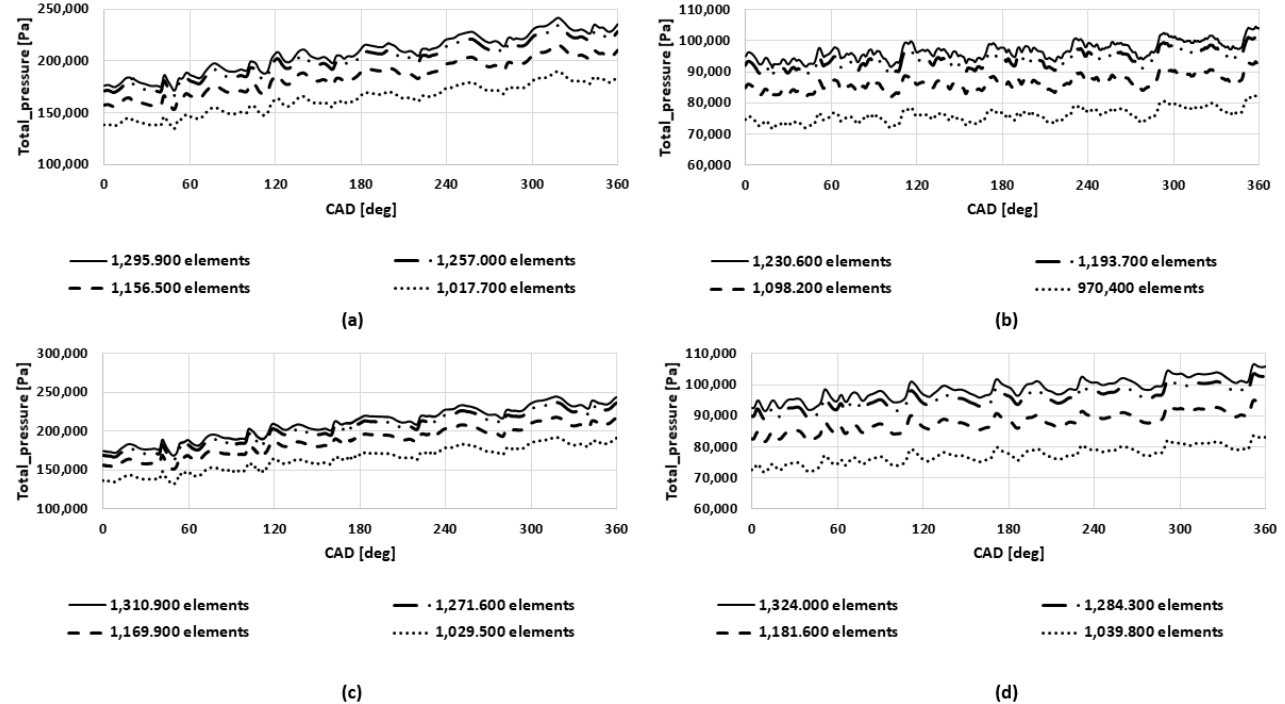
Figure 14. The mesh validation in terms of pressure variation of ( a ) rotor A — first-stage, ( b ) rotor A — second-stage, ( c ) rotor B — first-stage and ( d ) rotor B — second-stage during the single revolution of the crankshaft. Table 5. The total number of elements of two-stage system with rotor A and rotor B.